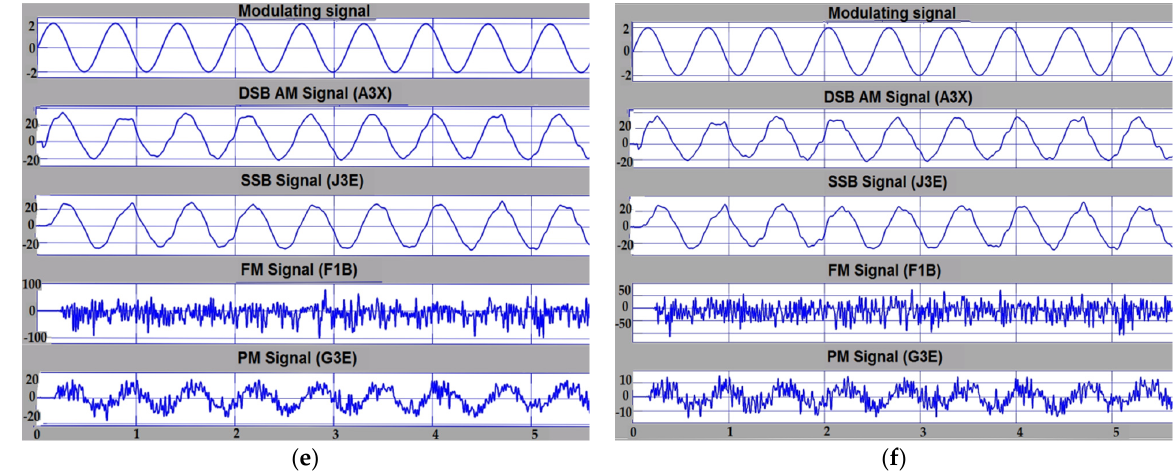
Figure 5. Simulation results using the diagram in Figure 4, for different values of the noise signal ratio (SNR) at the demodulator input port: ( a ) SNR = 20 dB, for MP Δφ = π /2; ( b ) SNR = 20 dB, for MP Δφ = π /3; ( c ) SNR = 10 dB, for MP Δφ = π /3; ( d ) SNR = 3 dB, for MP Δφ = π /3; ( e ) SNR = 0 dB, for MP Δφ = π /3; ( f ) SNR = − 3 dB, for MP Δφ = π /3.